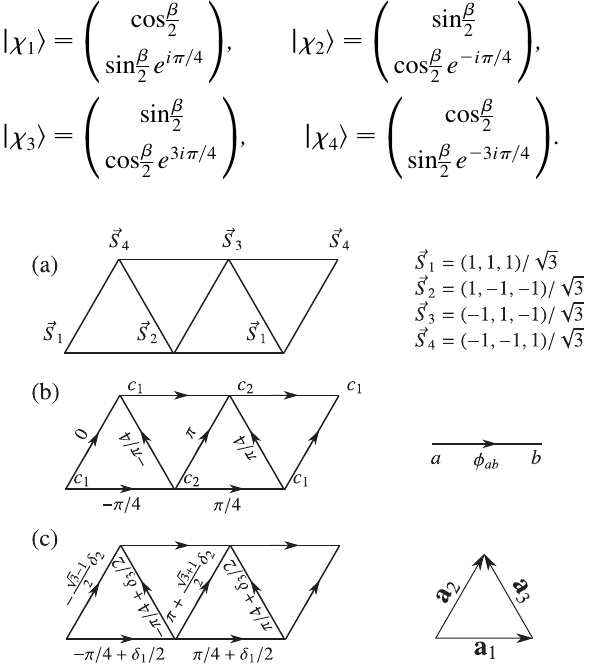
FIG. 5. (a) Spin components for the texture of Fig. 1(a). (b) The phases (cid:6) ab of the hopping amplitude on different links of the lattice. The hopping Hamiltonian can then be written as a 2 (cid:6) 2 matrix in the basis represented by c (cid:6) ab of the hopping amplitude in the presence of a vortex [see Eq. (14)], and the lattice vectors a i